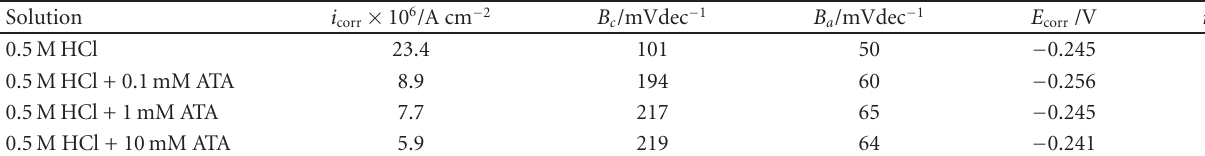
Figure 2. The values were tabulated in Table 2. In acid